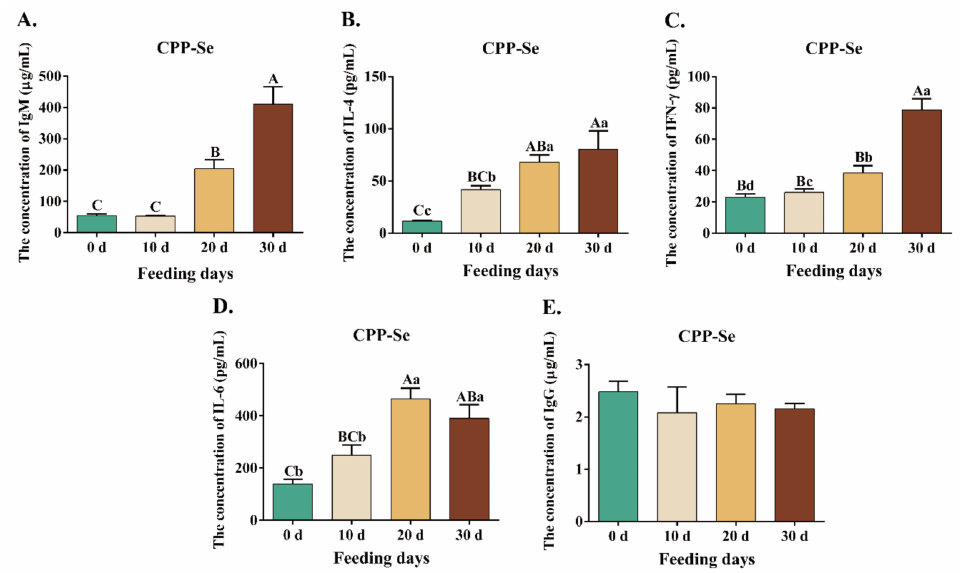
Figure 4. Changes in the content of IgM ( A ), IL-4 ( B ), IFN- γ ( C ), IL-6 ( D ) and IgG ( E ) during the feeding period. Different lowercase letters represent the level of significance at p < 0.05; different uppercase letters represent the level of significance at p < 0.01.